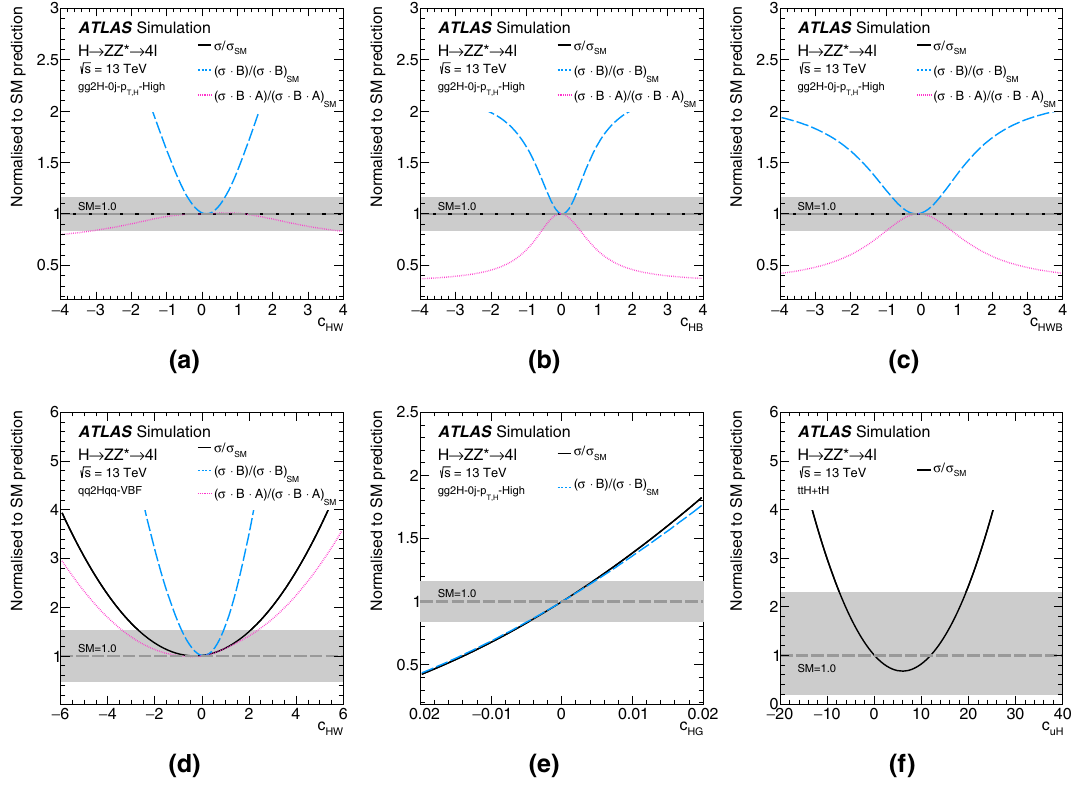
Fig. 13 The dependence of the signal acceptance normalised to the SM acceptance on the Wilson coefficients ( a ) c HW and c c , ( c ) c HWB and c after setting all other coefficients to zero H ˜ B H ˜ WB